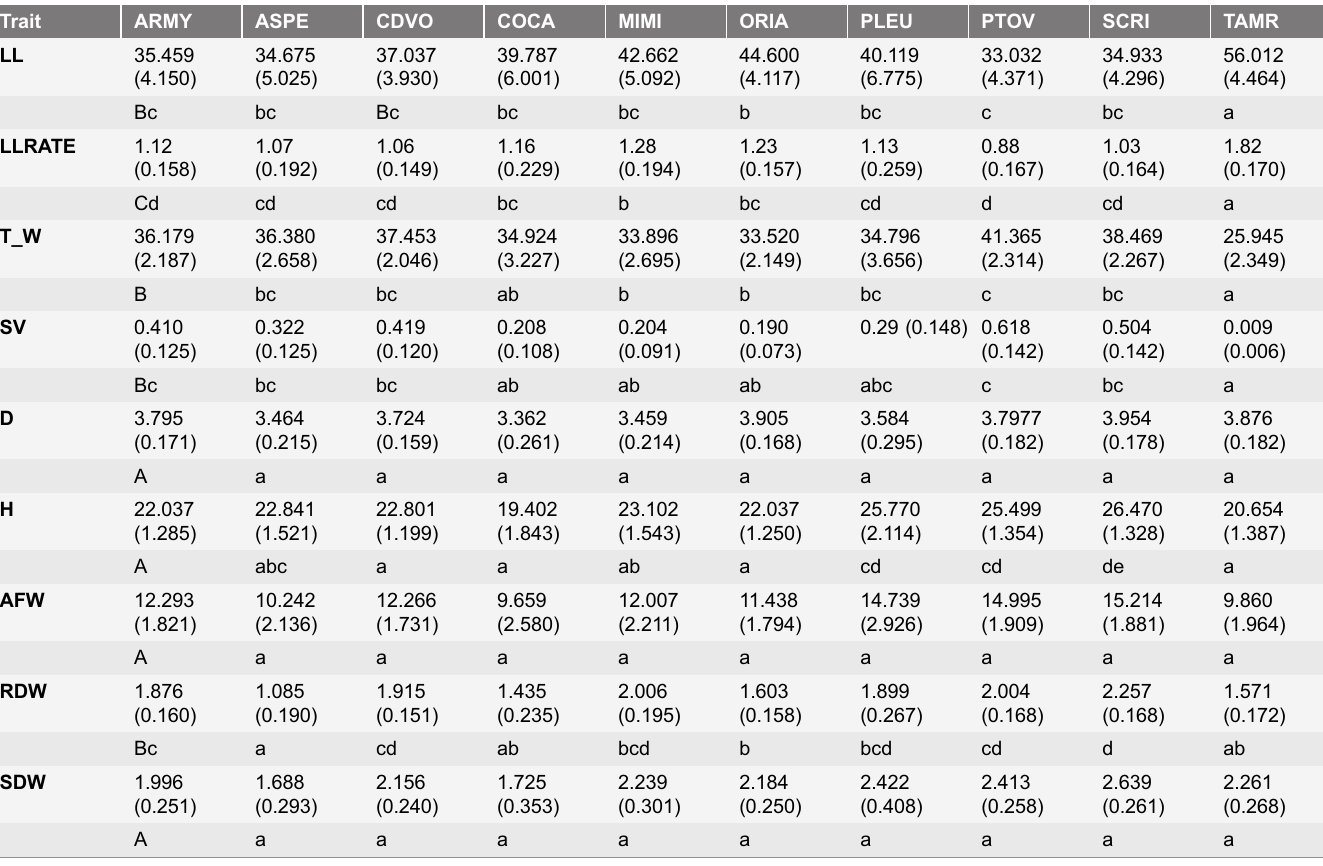
LL: lesion length (mm) of plants with or without dieback at sampling date, LLRATE: lesion length growth per day, T _ W: time (days) to first symptoms of wilting above inoculation point, SV: proportion of plants without wilting at the end of experiment, D: stem diameter (mm) at the inoculation point, H: stem height (mm), AFW: aerial fresh weight (g), RDW: root dry weight (g), SDW: stem dry weight (g). Means with the same letter did not differ significantly, according to Tukey-Kramer test (p , 0.05) for all variables except SV, in this case Wilcoxon test was used. Populations described in Table